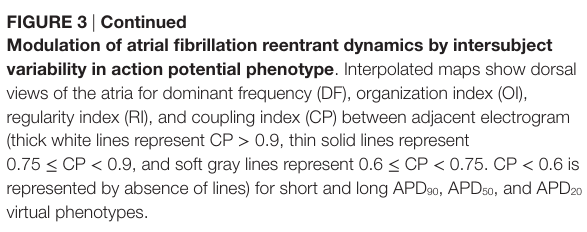
FigUre 3 | continued Modulation of atrial fibrillation reentrant dynamics by intersubject variability in action potential phenotype . Interpolated maps show dorsal views of the atria for dominant frequency (DF), organization index (OI), regularity index (RI), and coupling index (CP) between adjacent electrogram (thick white lines represent CP > 0.9, thin solid lines represent 0.75 ≤ CP < 0.9, and soft gray lines represent 0.6 ≤ CP < 0.75. CP < 0.6 is represented by absence of lines) for short and long APD 90 , APD 50 , and APD 20 virtual